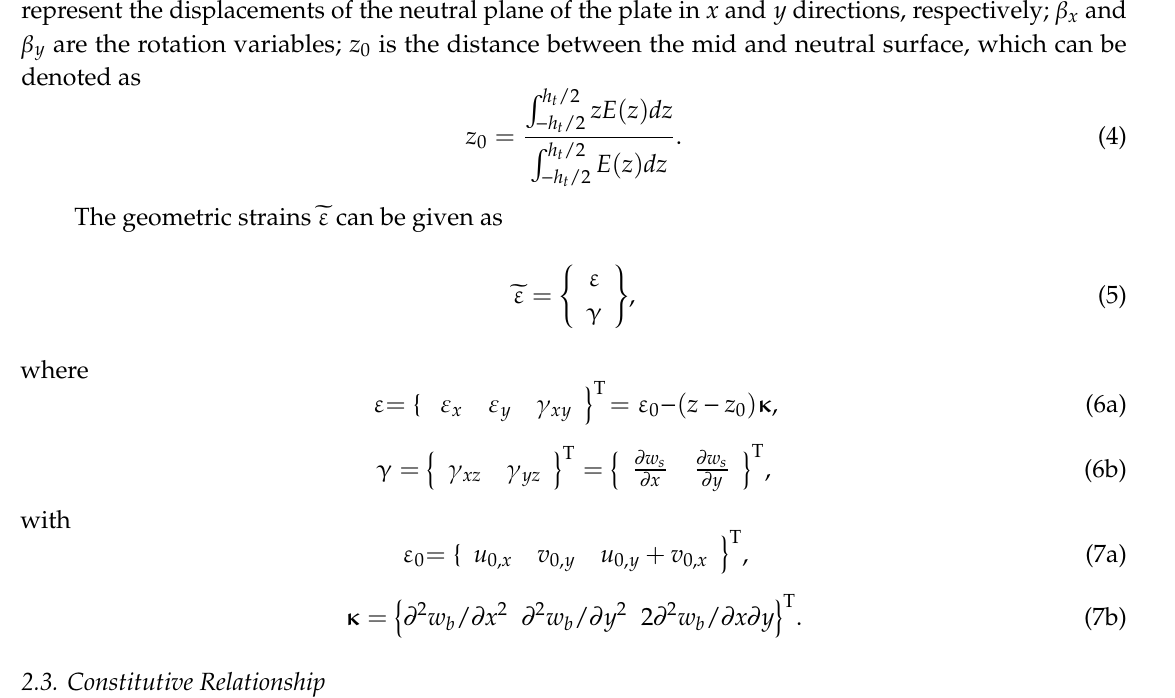
Figure 2. The volume fraction of the metal